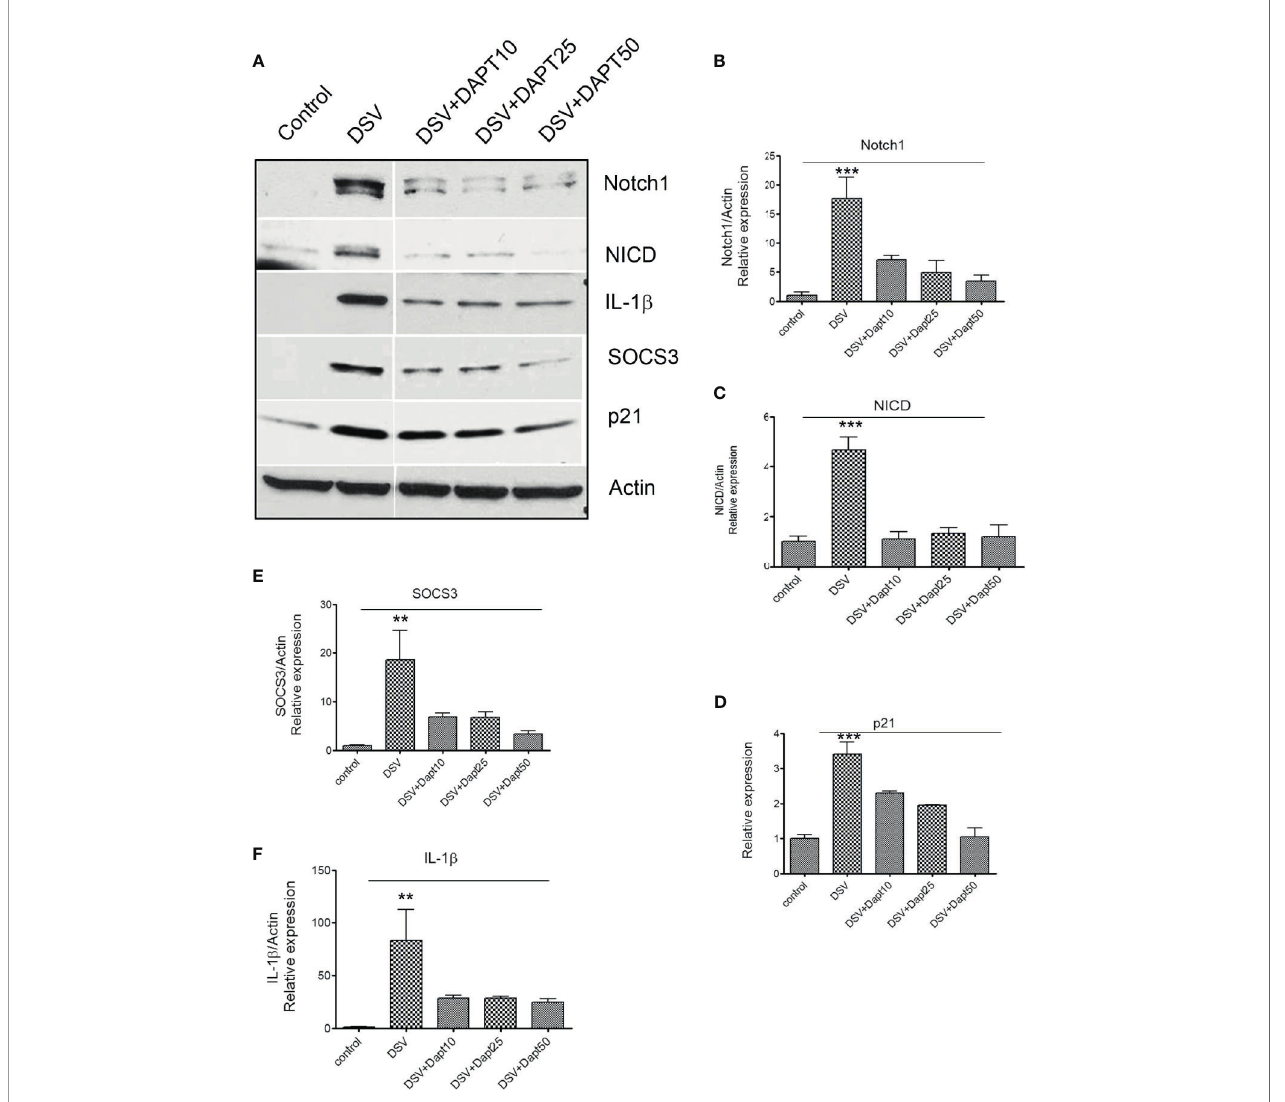
FIGURE 3 | DSV-induced Notch signaling, SOCS3, and pro-IL-1 b expression is inhibited by gamma secretase inhibitor DAPT (A) RAW cells (8x10 5 ) were treated with various concentrations of DAPT (10, 25, and 50 µm in DMSO) overnight. The following day, cells were infected with DSV (MOI 20) for 7 hours. Cells were lysed and protein lysate was prepared. Fifty m g of protein lysate was separated on SDS-PAGE and analyzed for Notch1, NICD, SOCS3, IL-1 b , and p21 by Western blotting. Actin was used as a loading control. (B – F) Quanti fi cation of Western blots. Blots were quanti fi ed with ImageJ by analyzing the ratio of protein of interest/ Actin. Data represents Mean ± SEM from at least three independent experiments. One-way ANOVA was used to determine the statistical signi fi cance. Values were compared to control, with a post-hoc Dunnett ’ s test. **p < 0.01 and ***p < 0.001.